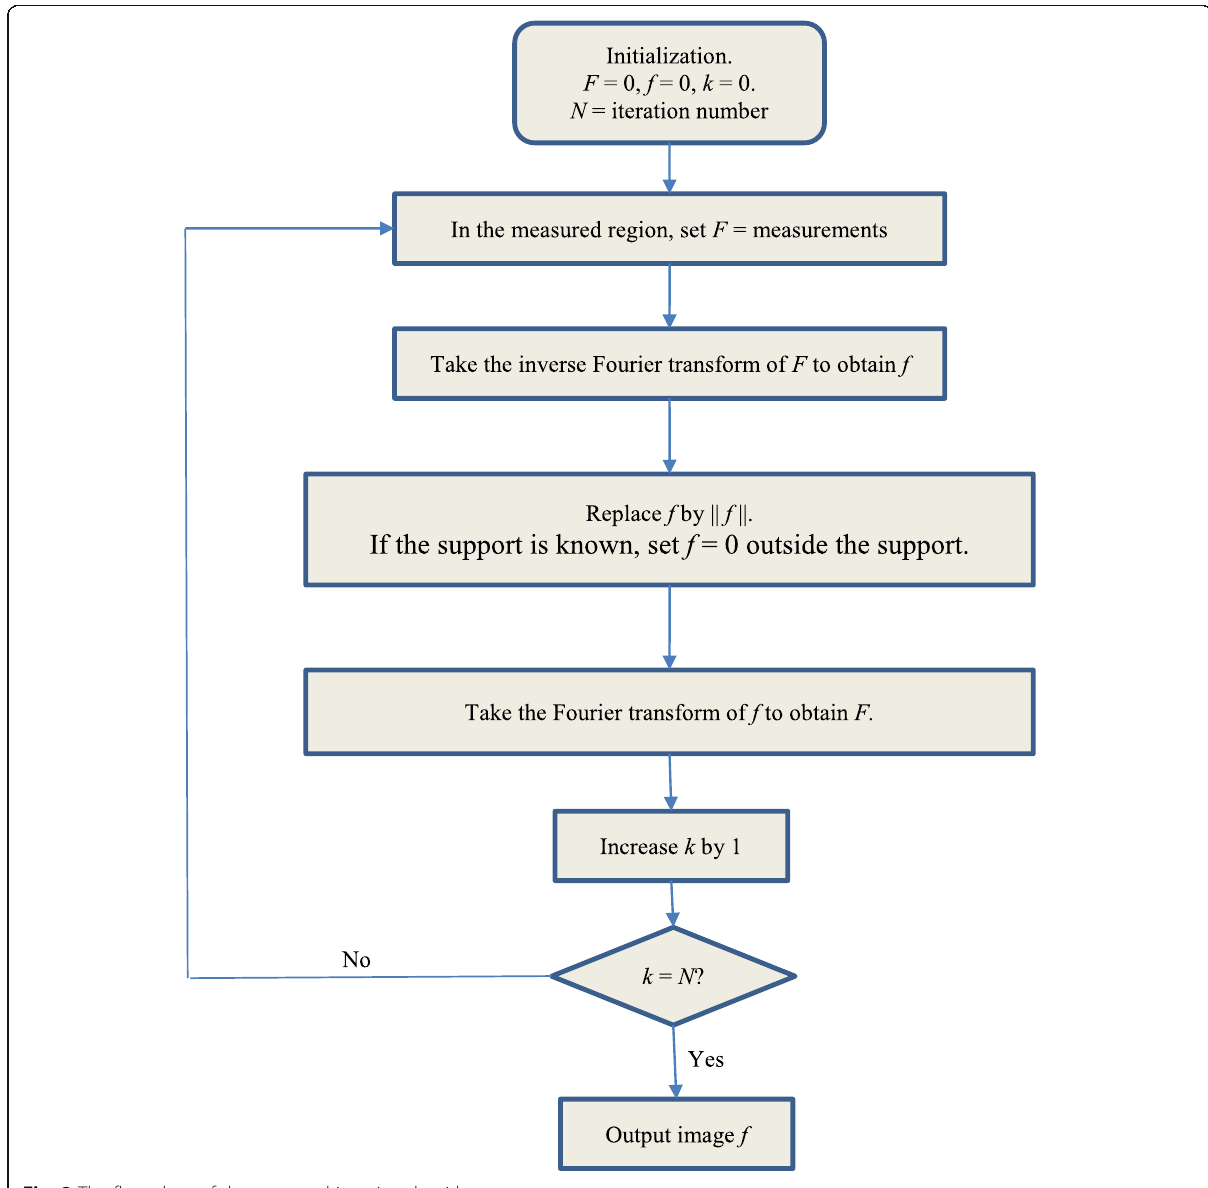
Fig. 2 The flow chart of the proposed iterative